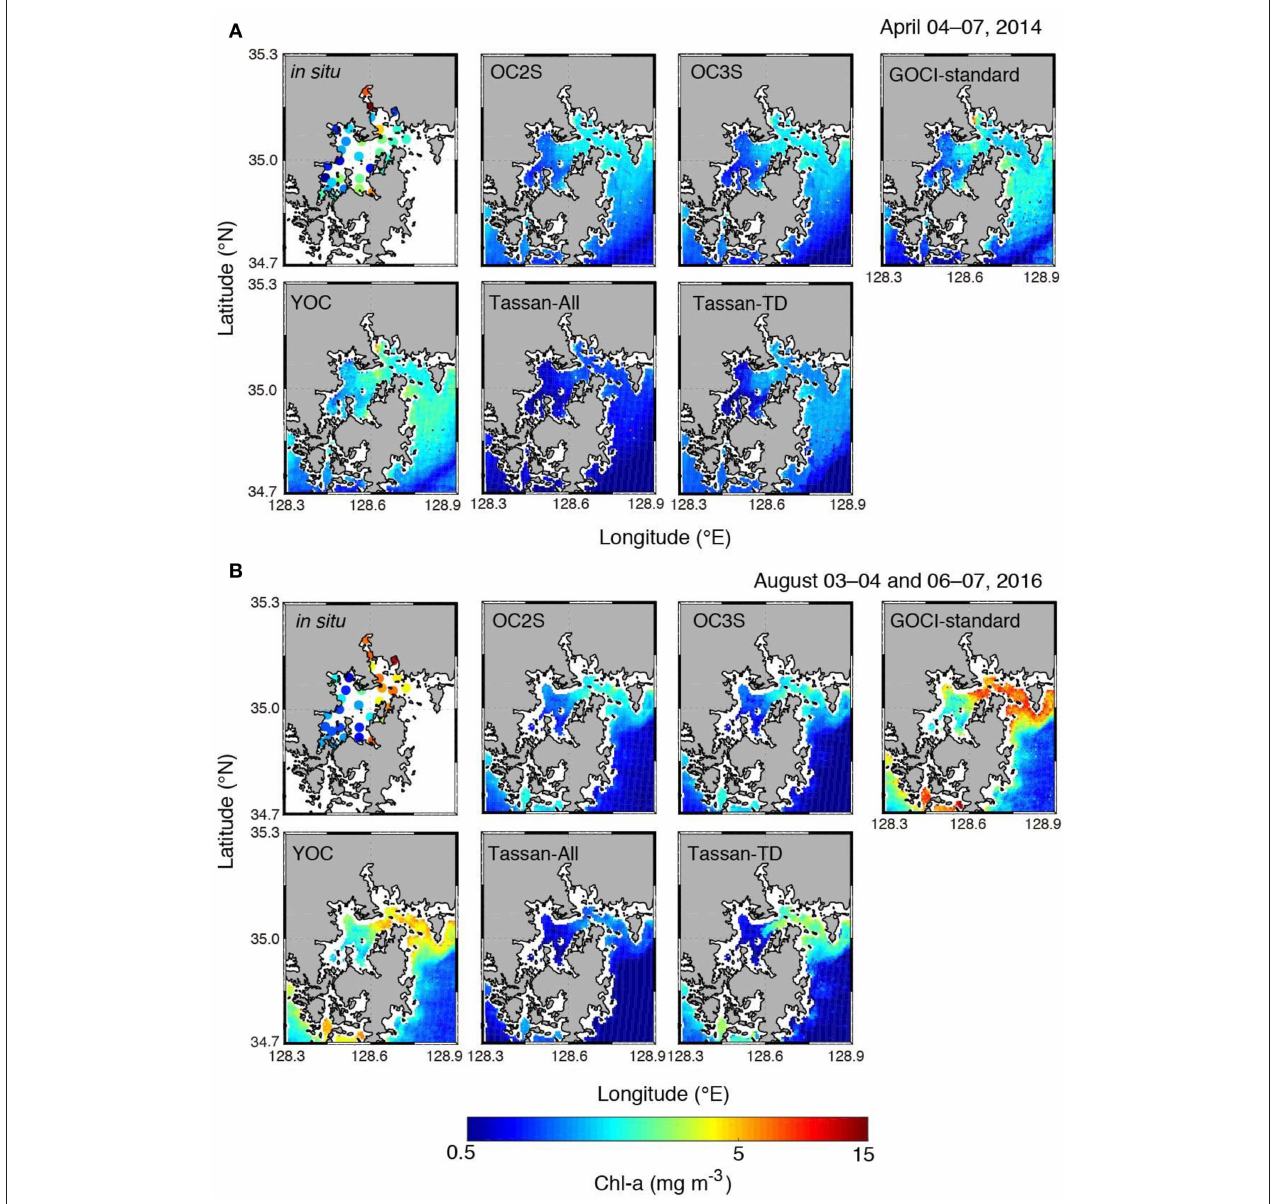
FIGURE 7 | Spatial distribution of in situ Chl-a (mg m − 3 ) and GOCI-derived Chl-a from six algorithms averaged for two sampling periods: (A) April 4–7, 2014 and (B) August 3–4 and 6–7, 2016, respectively. We excluded pixels with extreme concentrations (Chl-a < 0.001mg m − 3 or Chl-a > 500mg m − 3 ) and low-quality L2 data flagged as cloud or ice, land, atmospheric correction failure, unrealistic R rs spectrum shape, out of GOCI observation boundary, high solar zenith angle ( > 70 ◦ ), high satellite zenith angle ( > 55 ◦ ), or cloud edge from the